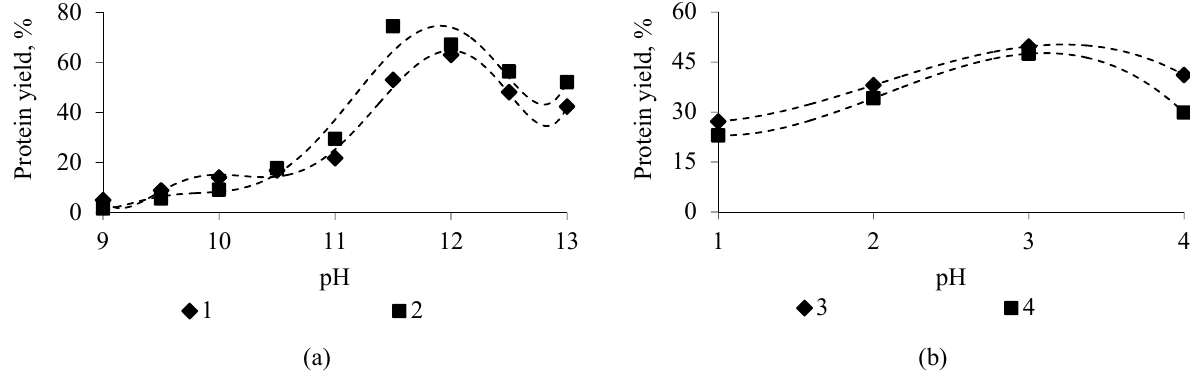
Fig. 8. Effect of pH of a medium in the process of alkaline (a) and acid (b) extraction on the yield of protein substances from the oat grains of the Rysak variety in the presence of: (1) 1 M of a potassium hydroxide solution; (2) 1 M of a sodium hydroxide solution; (3) of an aqueous hydrochloric acid solution; (4) of an aqueous sulfuric acid solution.